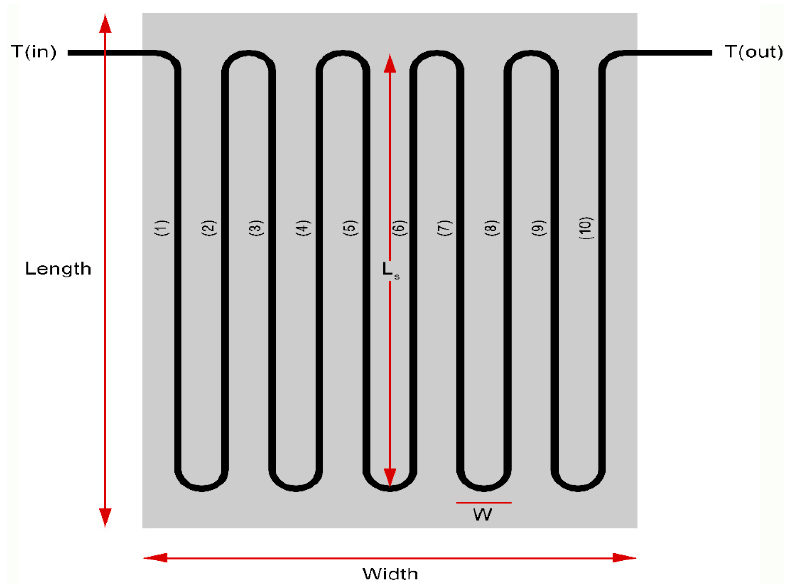
Figure 6. Schematic diagram of the proposed flat plate serpentine design with N = 10, W = 0.08 m, and Ls = 1.1 m. Table 2. Technical data on manufacturing serpentine tubes with elliptical and circular cross- sections.